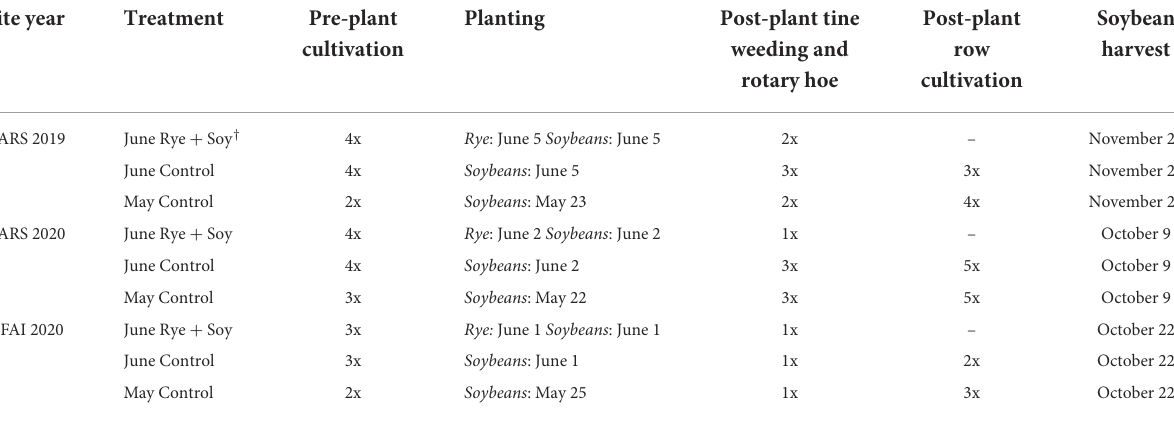
TABLE 1 Frequency of pre-plant and post-plant tillage operations for spring-seeded rye and tilled control treatments located at the Arlington Agricultural Research Station (AARS) in Arlington, WI and the Michael Fields Agricultural Institute (MFAI), East Troy, WI, 2019–2020. Site